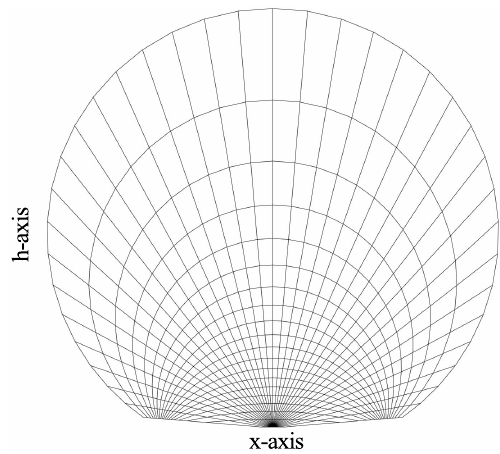
Figure A2. Coordinates grid for a fixed φ